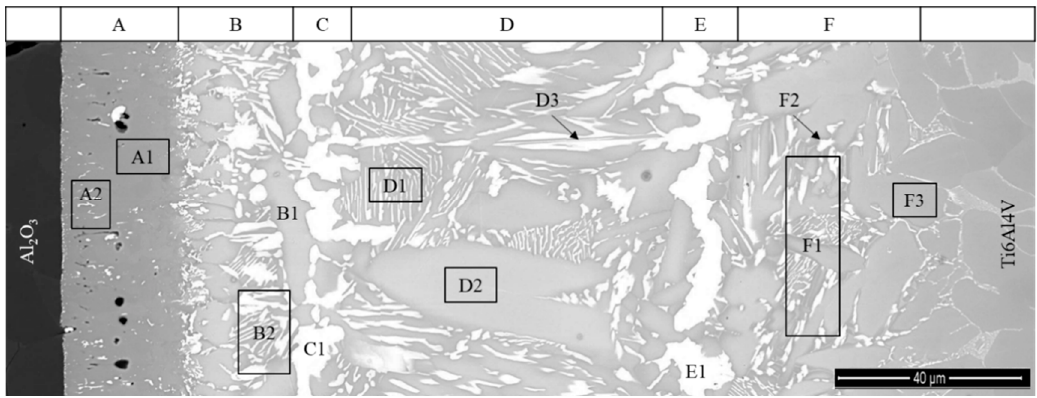
Figure 6. SEM image of the Al 2 O3/Ti6Al4V interface with marked EDS analysis zones in the reaction layers ( A – F ) of the interface .